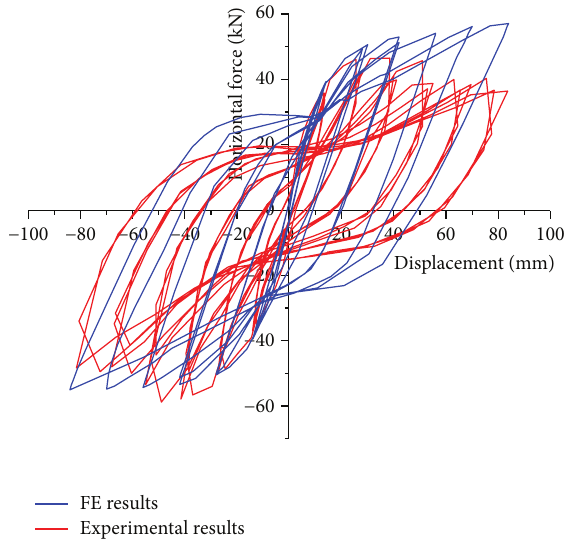
Figure12:Comparisonofthehystereticcurvesbetweenexperimen- tal results and FE results of the steel tube repaired pier.